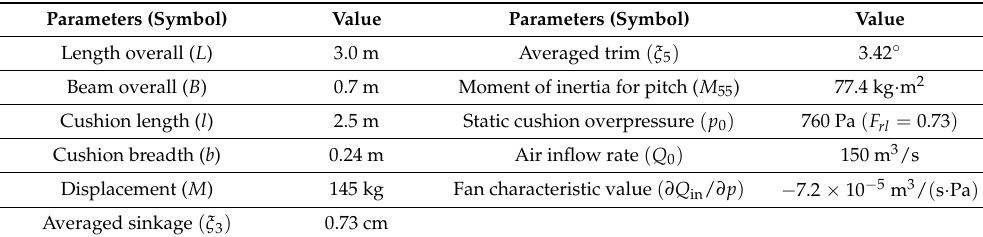
Table 2. Main characteristics of the PACSCAT [6].